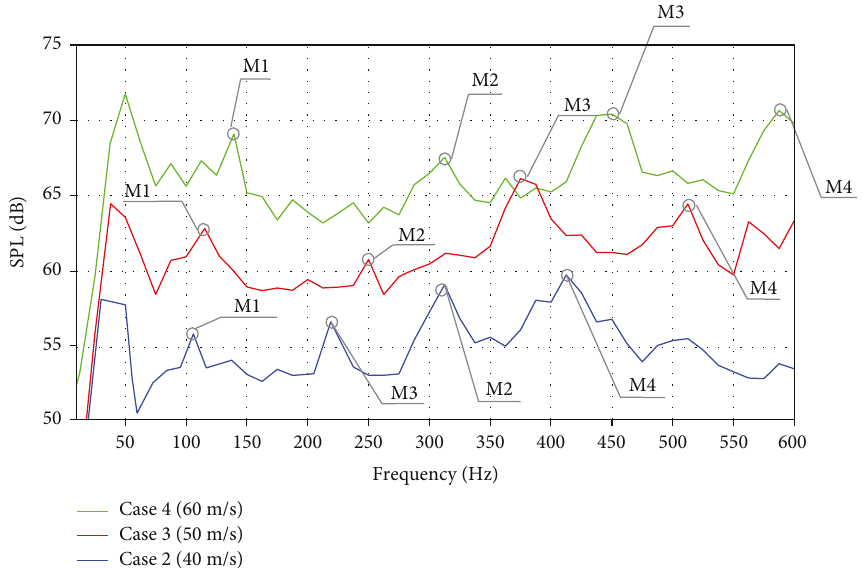
Figure 10: Shear layer modes of the test